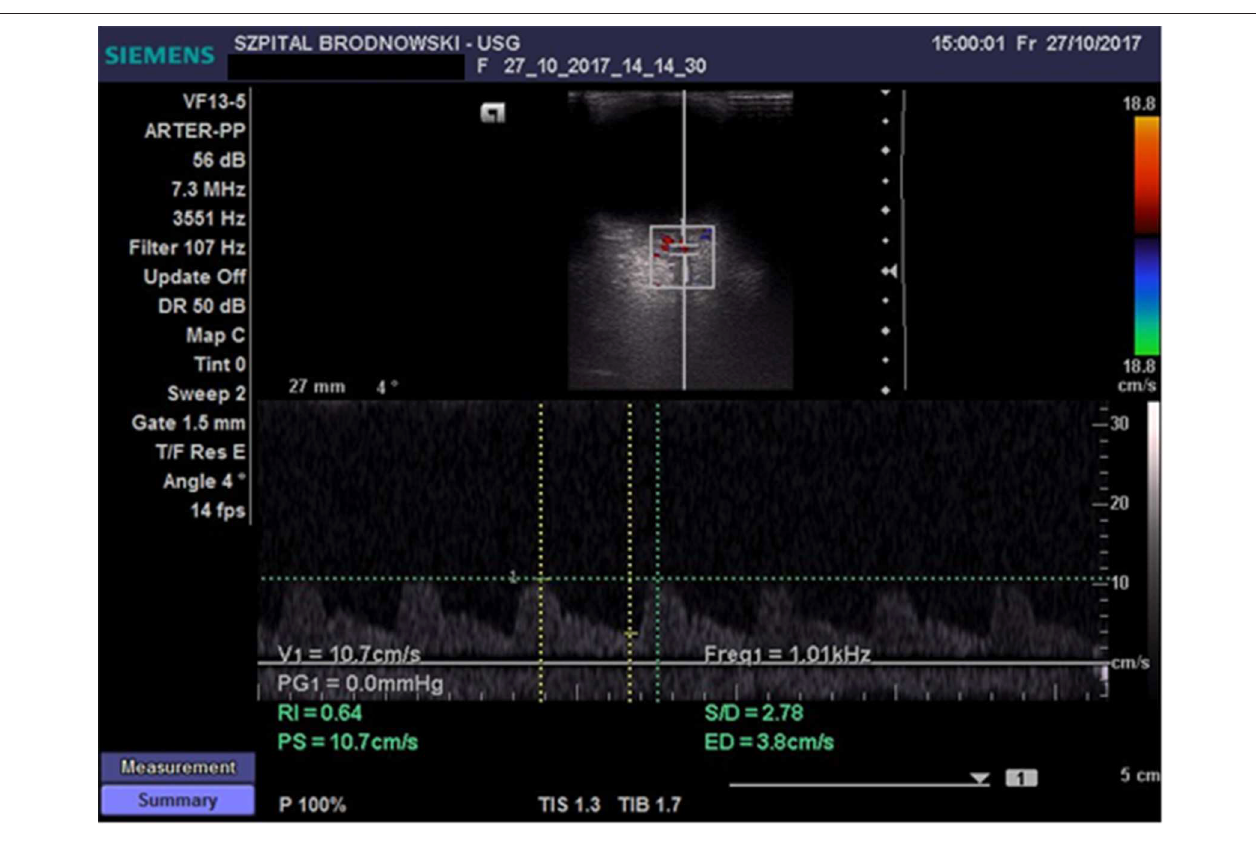
FIGURE 2 | Flow velocity waveform in the central retinal